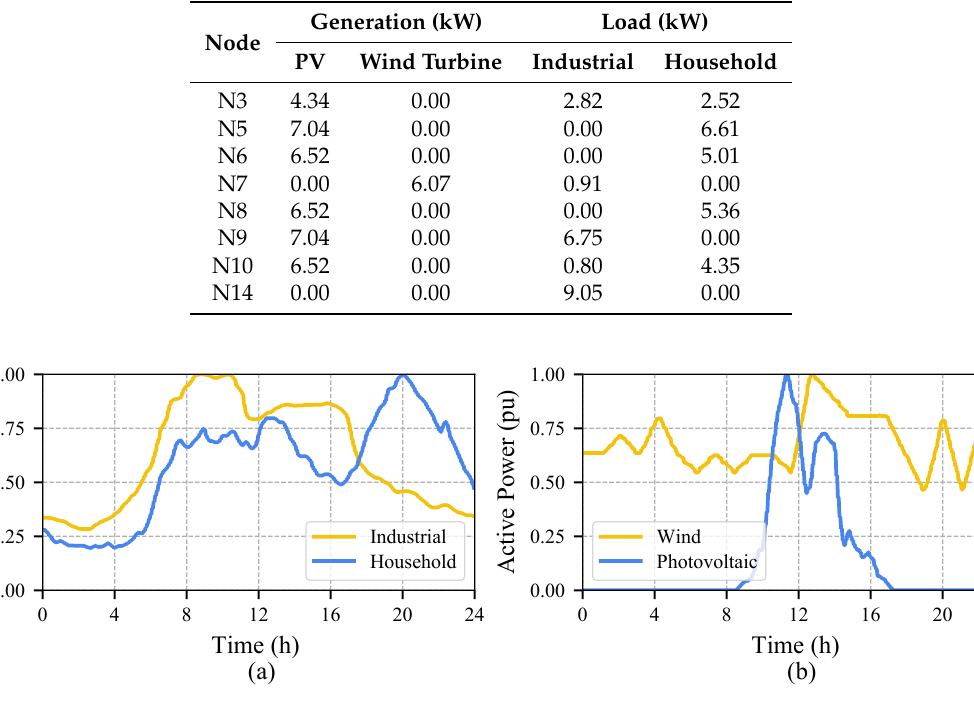
Figure 9. PSHIL application example. Daily profiles in per-unit ( a ) Load profiles, ( b ) Generation